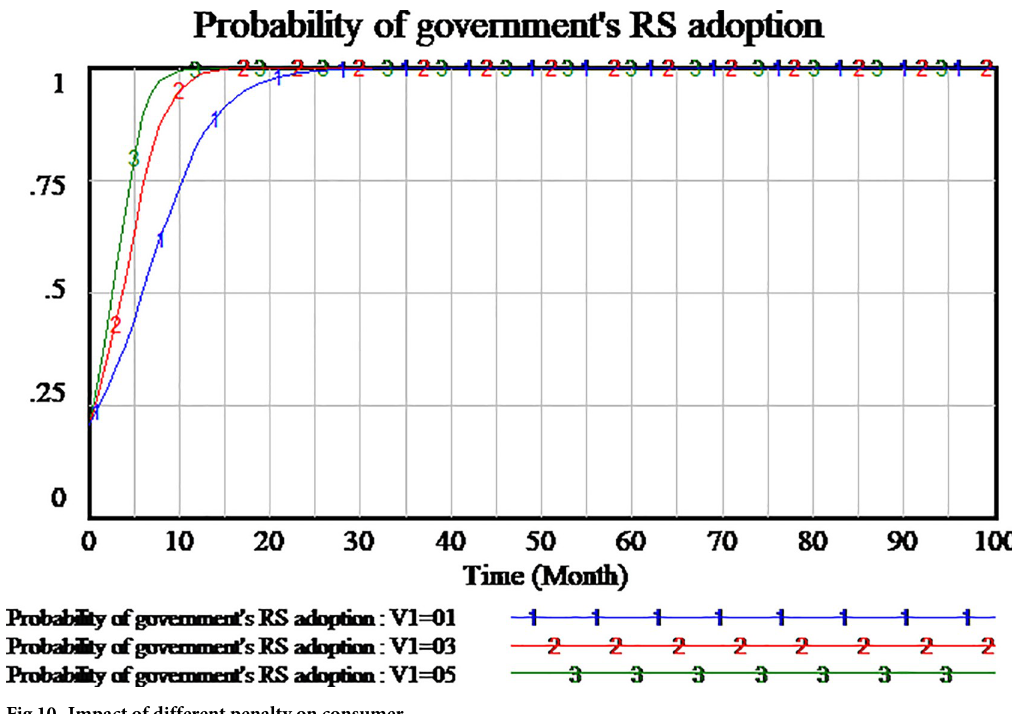
Fig 10. Impact of different penalty on consumer.